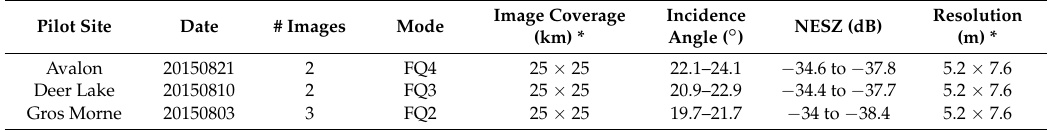
Table 2. Characteristics of RADARSAT-2 imagery used in this